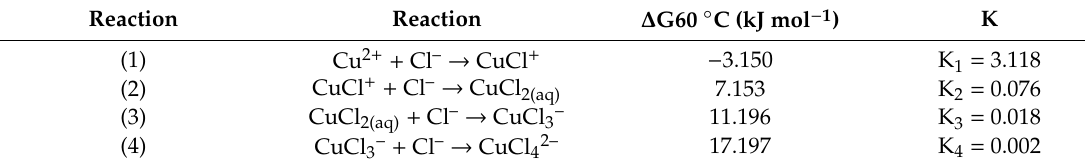
Table 3. Formation data for cupric chloride